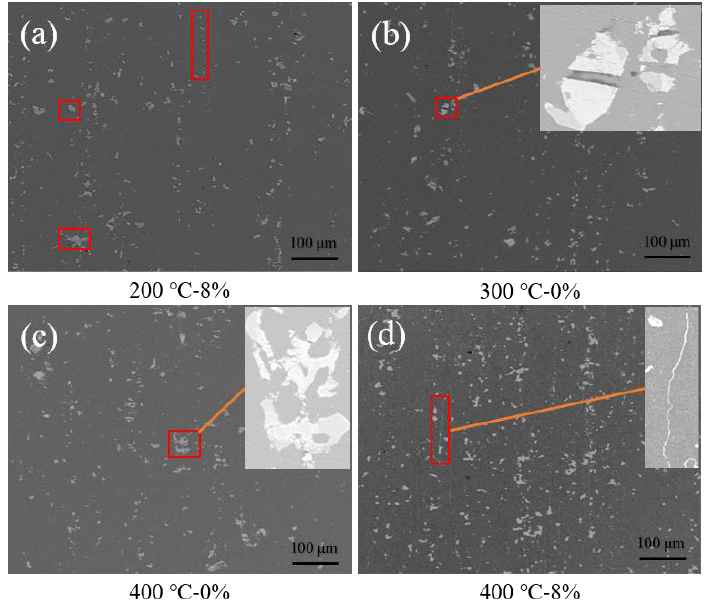
Figure 4. Precipitated phase morphology under different thermal strain conditions. ( a ) 8% pre-strain was given at peak temperature of 200 ℃ ; ( b ) Without strain under peak temperature of 300 ℃ ; ( c ) Without strain under peak temperature of 400 ℃ ; ( d ) 8% pre-strain was given at peak temperature of 400 ℃ .